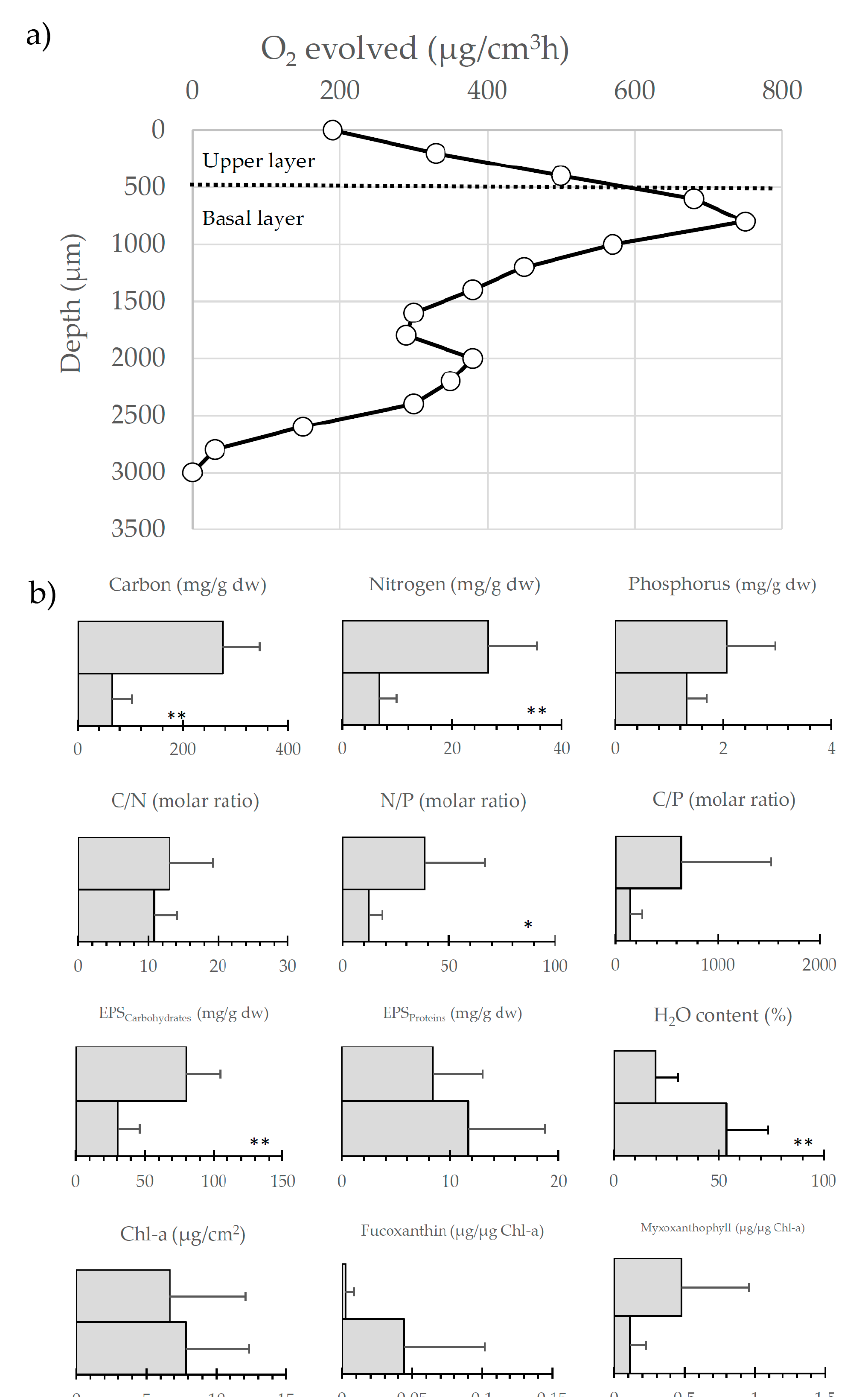
Figure 8. Functional structure of a typical microbial mat from Byers Peninsula: ( a ) Vertical profiles of oxygen evolution within the mat measured with microelectrodes; ( b ) Allocation, in the surface and basal layers, of different structural characteristics. Variables are major nutrients and their molar ratios, exopolysaccharides (EPS), both carbohydrates and proteins, percentage of water content, and main photosynthetic pigments. The latter include taxa specific carotenoids for the main photosynthetic organisms, fucoxanthin, as the main marker for diatoms, and myxoxanthophyll, as the main marker for cyanobacteria. One or two asterisks indicate statistical differences with significance at p < 0.05 and p < 0.01 respectively, between both layers.